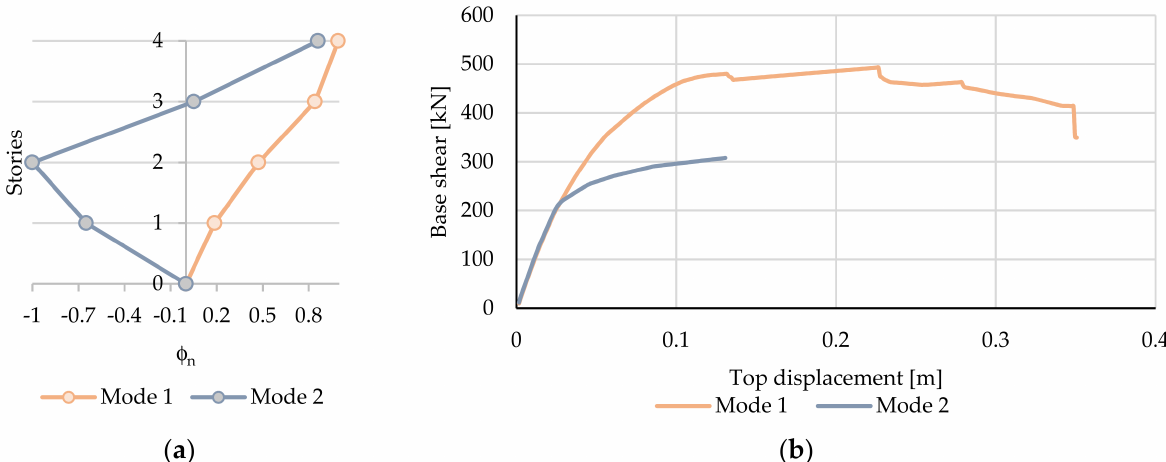
Figure 7. ( a ) First and second modal shapes and ( b ) capacity curves of the